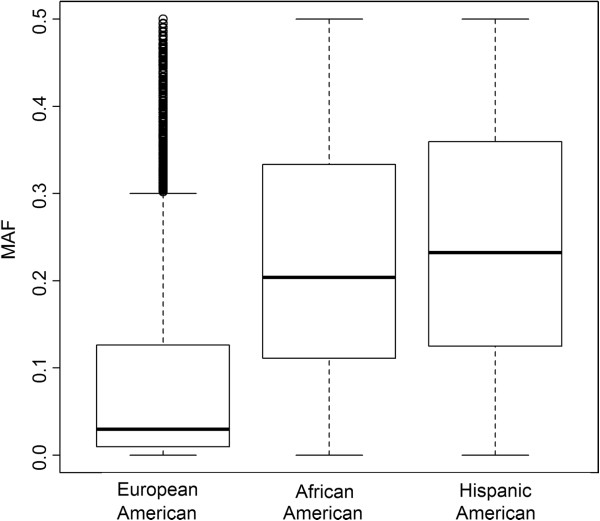
Box and whisker plots of MAF of the top 5,000 SNPs for each population. The MAFs were estimated using affected offspring. The bottom and top of the box are the lower and upper quartiles, respectively, the band within the box is the median, and the ends of the whiskers are the lowest/highest data value within 1.5 IQR of the lower/higher quartile. IQR is the difference between the upper and the lower quartiles.